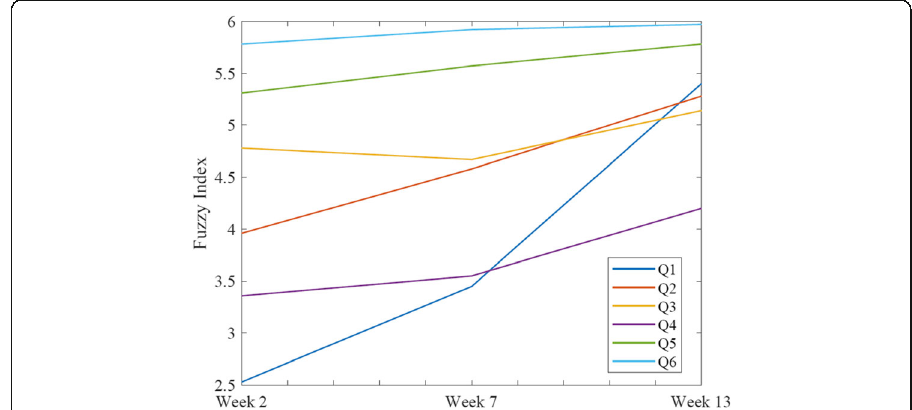
Fig. 6 Fuzzy indices for survey responses from three